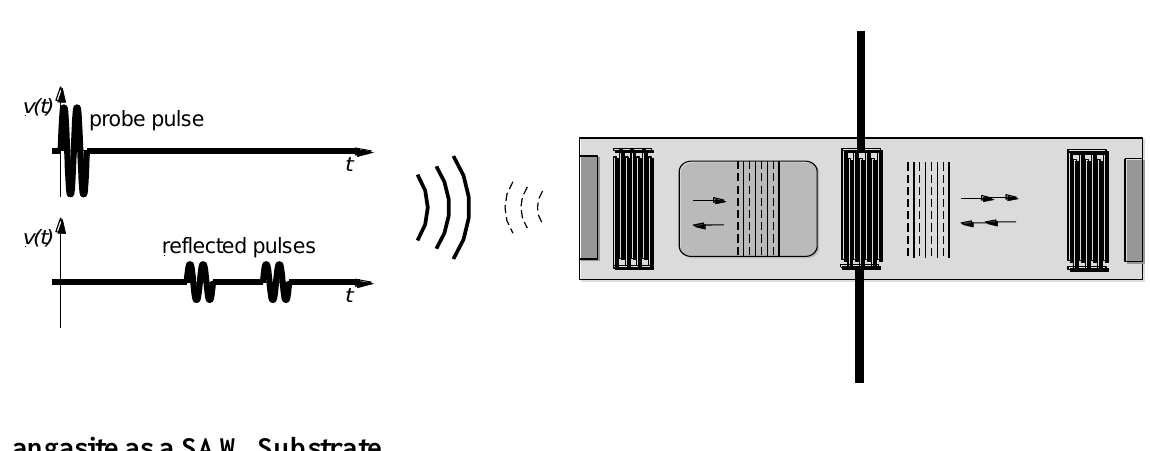
Figure 4. The wireless sensing